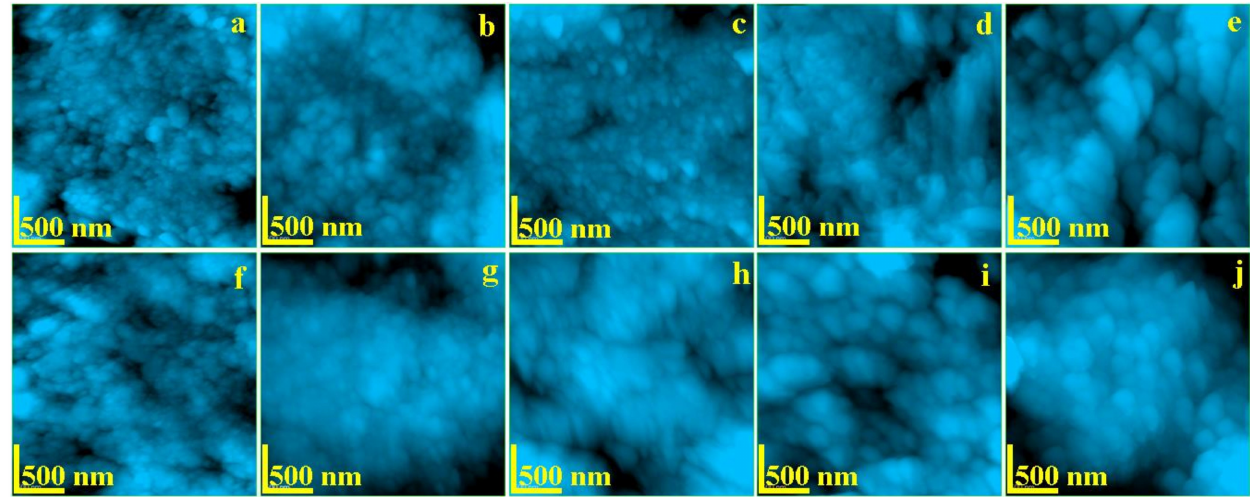
Figure 4. AFM topographic images of: Enamel—( a ) no exposure, ( b ) exposed 6 h, ( c ) exposed 12 h, ( d ) exposed 48 h, and ( e ) exposed 8 days; Dentine—( f ) no exposure, ( g ) exposed 6 h, ( h ) exposed 12 h, ( i ) exposed 48 h, and ( j ) exposed 8 days. Scanned area 2.5 × 2.5 µ